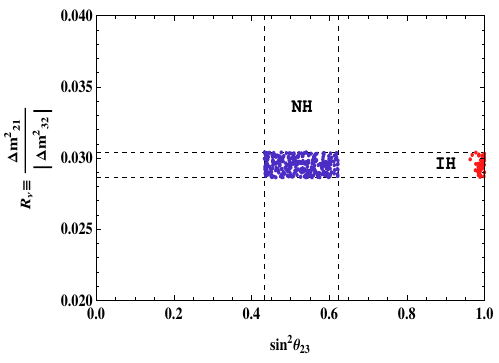
Figure 7 . Allowed parameter space in ( sin 2 θ 23 - R ν ) plane for normal and inverted hierarchies. Horizontal (Vertical) lines represent 3 σ experimental limits of R